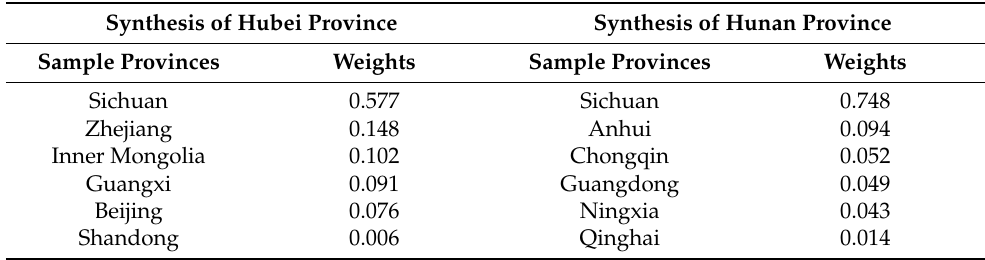
Table 2. Nonzero weights of samples for synthetic total emissions of industrial wastewater. Synthesis of Hubei Province Synthesis of Hunan Province Sample Provinces Weights Sample Provinces Weights Sichuan